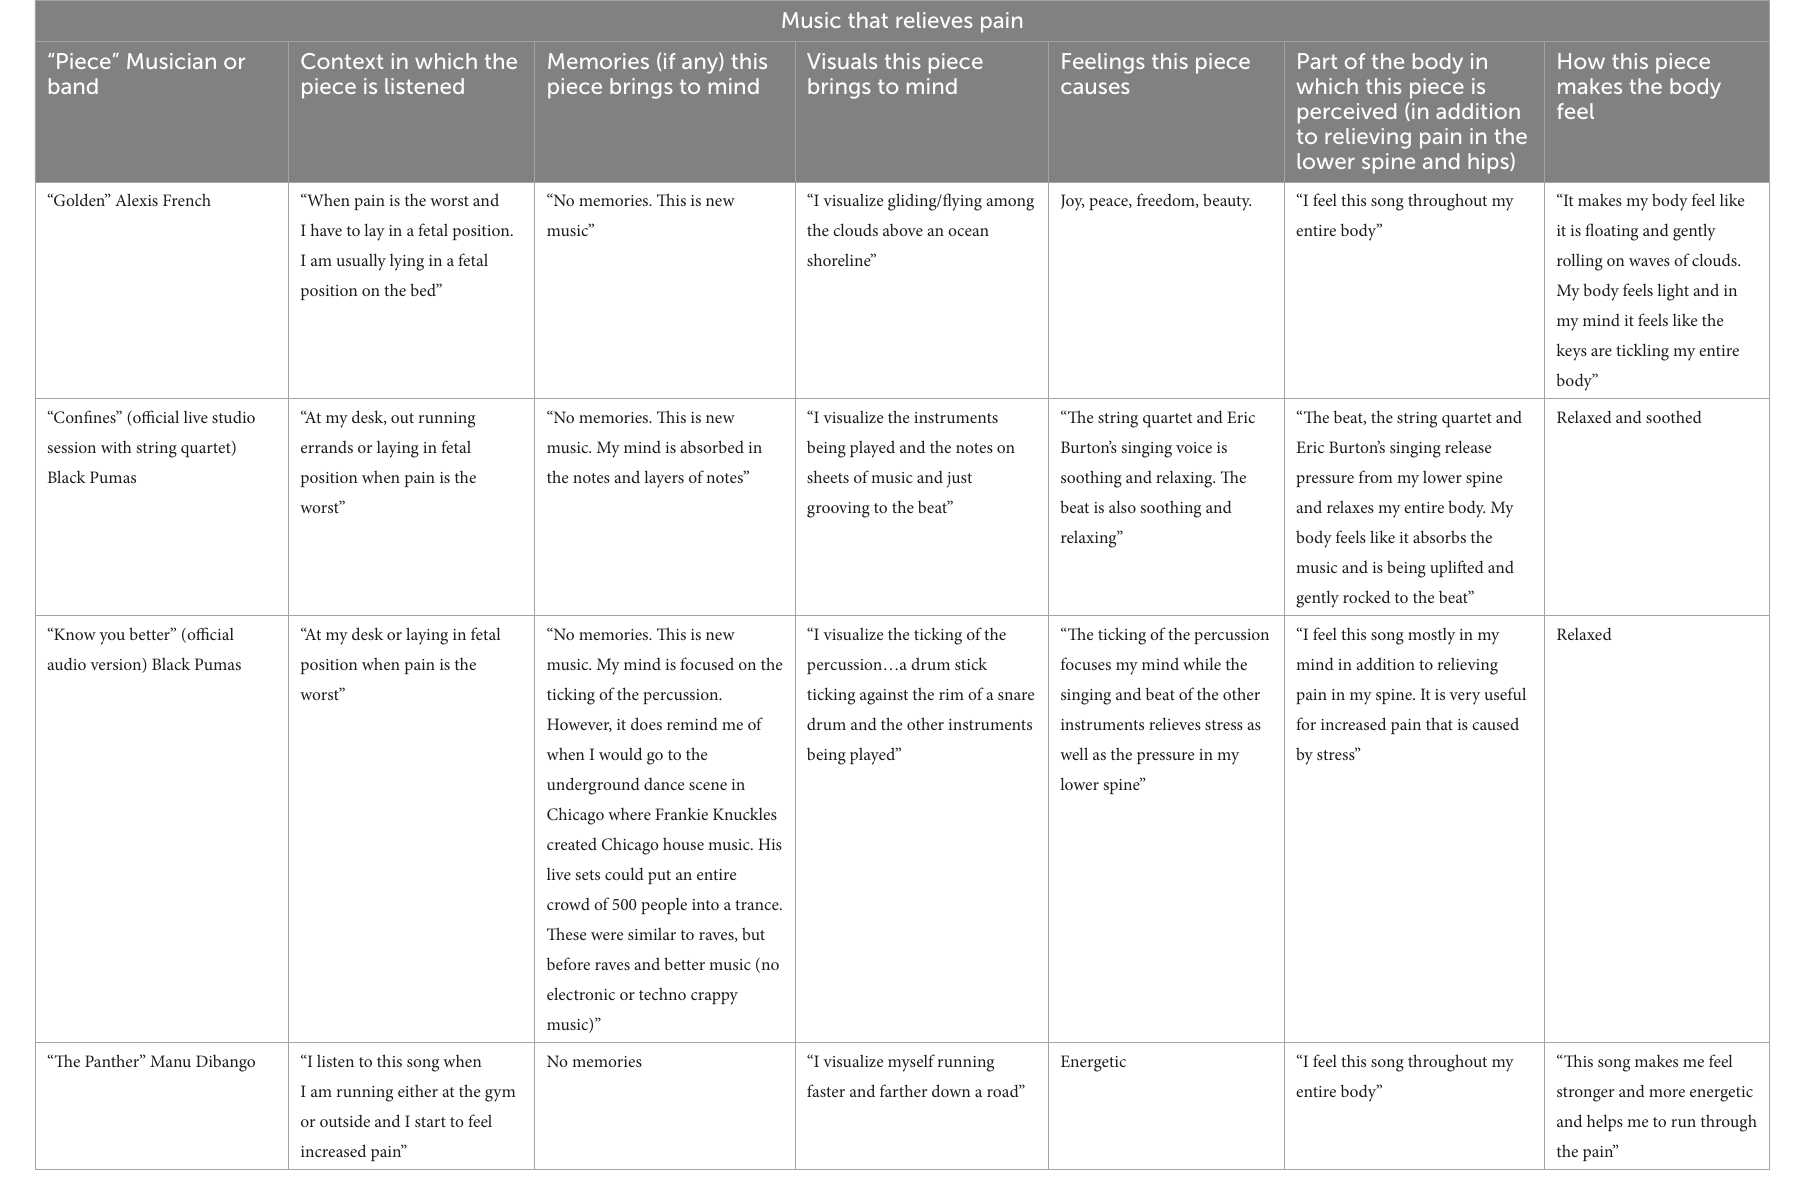
Music that relieves pain